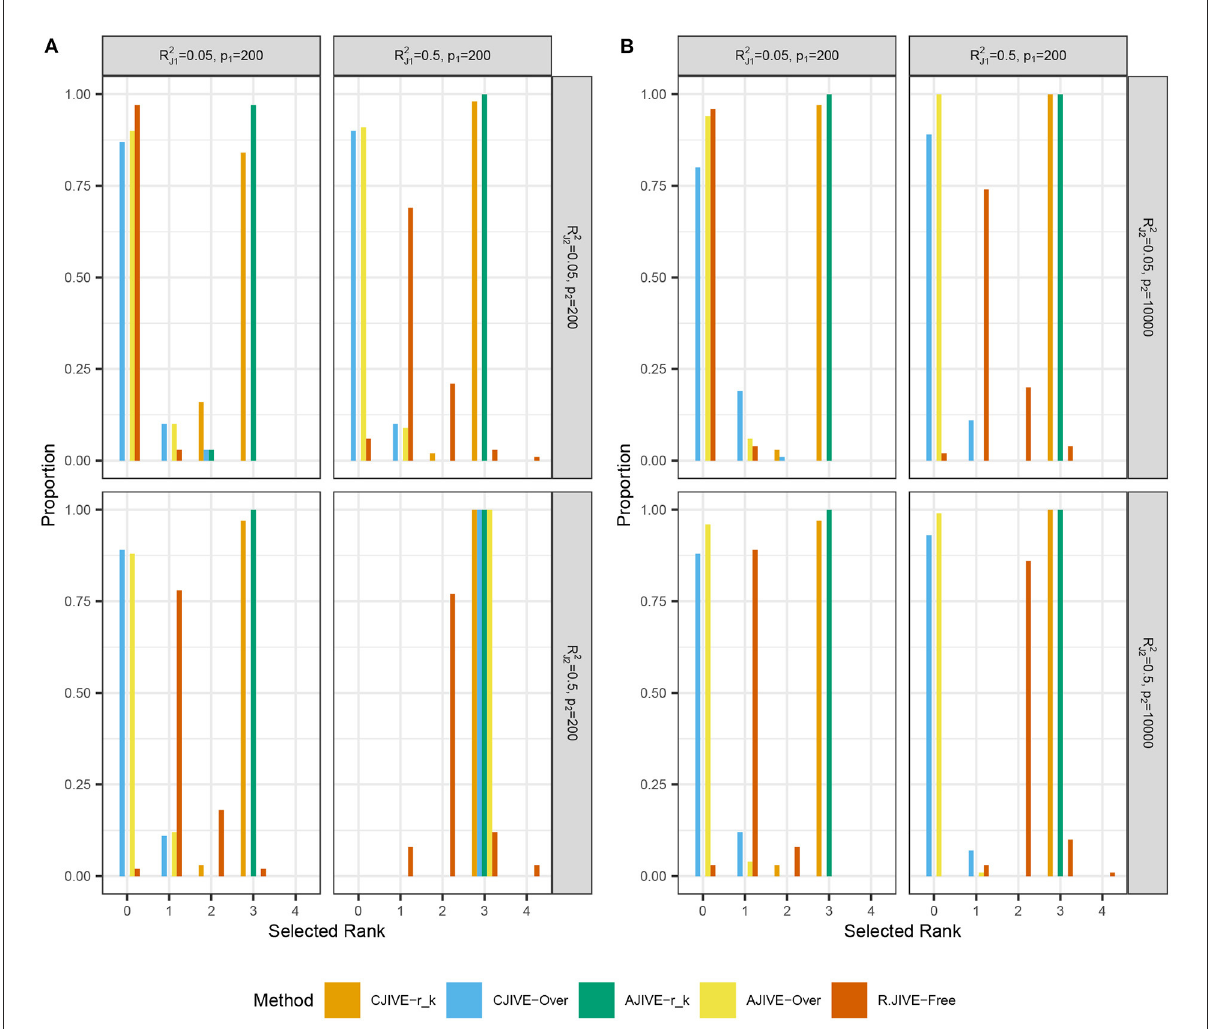
FIGURE2 Results of simulation studies: (A) p 2 combination of simulation settings. True joint rank equals 3 in all simulations. R 2 J 1 and R 2 J 2 represent the true joint variation controlled in simulations. We held the sample size and individual variation explained constant at n AJIVE- r k and CJIVE- r k are not possible in practice, as the signal ranks must all be